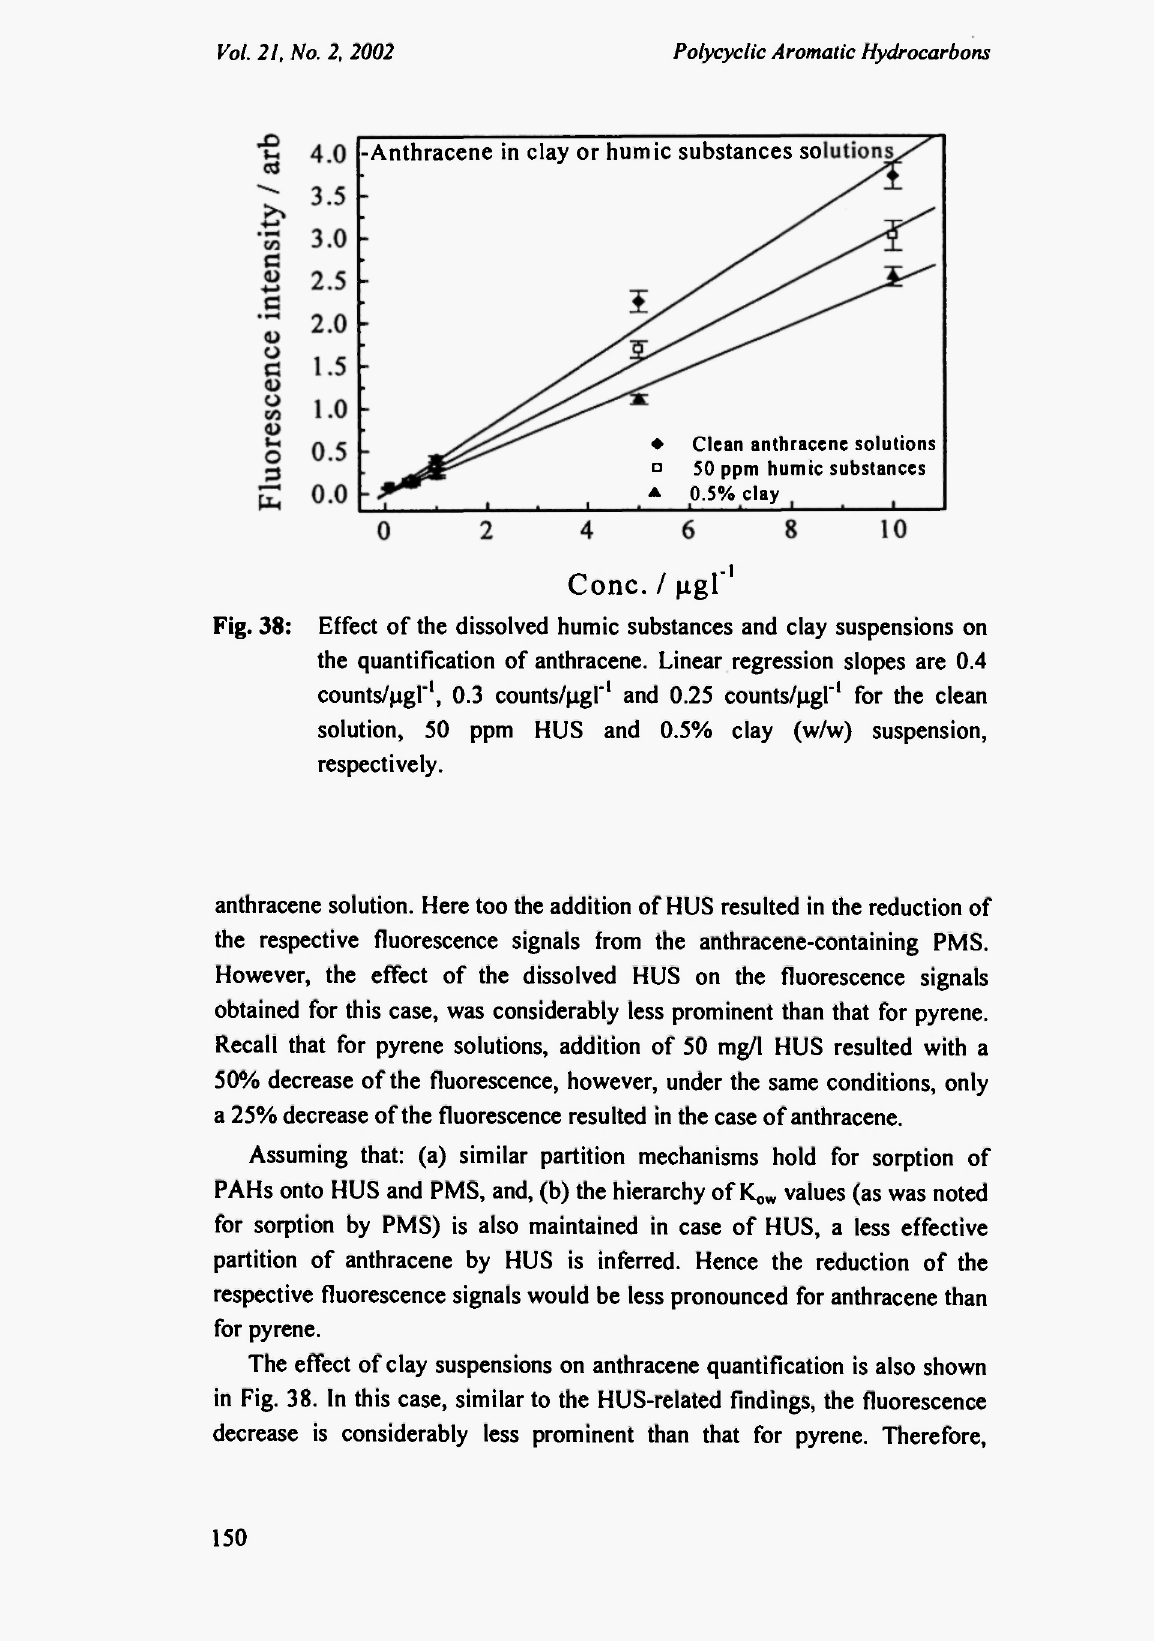
Fig. 38: Effect of the dissolved humic substances and clay suspensions on the quantification of anthracene. Linear regression slopes are 0.4 counts/^gl" 1 , 0.3 counts^gl" 1 and 0.25 counts^gl" 1 for the clean solution, 50 ppm HUS and 0.5% clay (w/w) suspension,